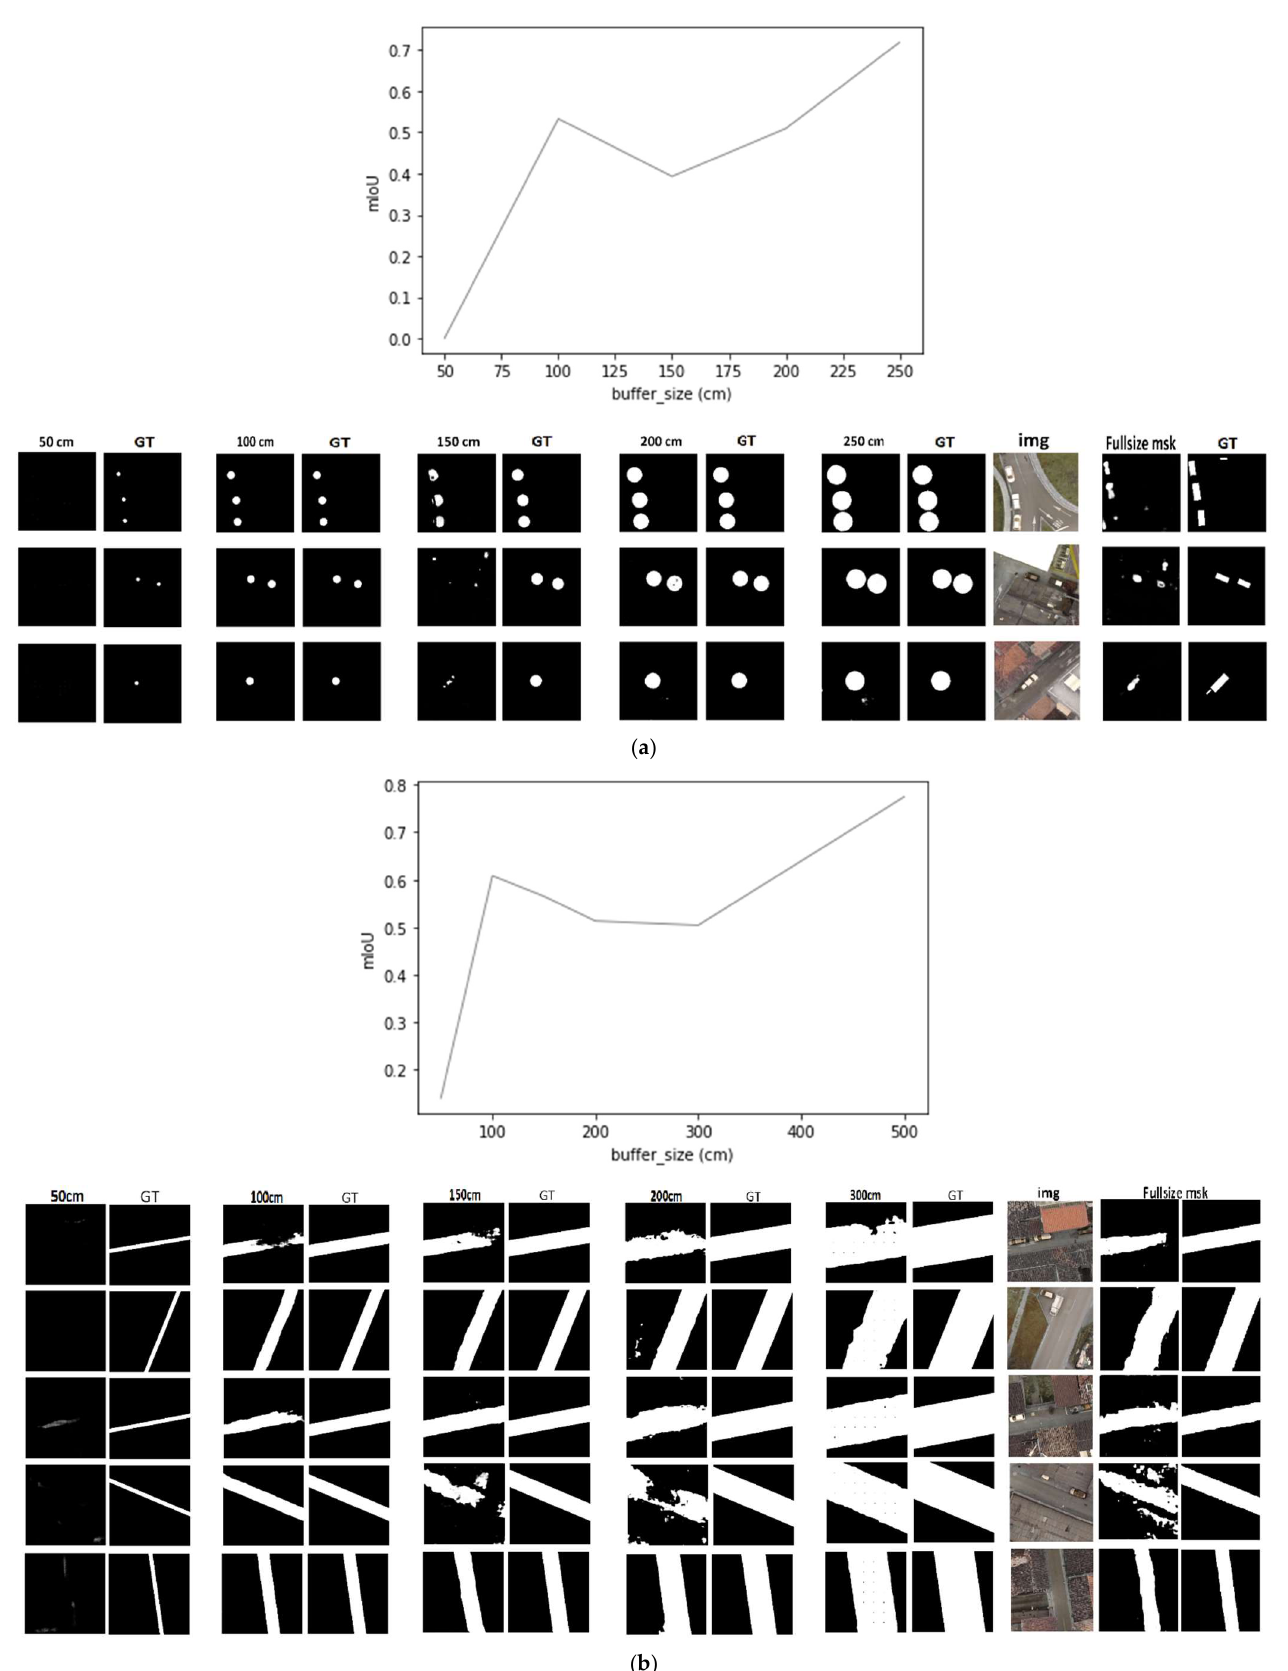
Figure 10. Segmentation results mIoU vs. mask buffer size. ( a ) Vehicles, ( b ) roads.